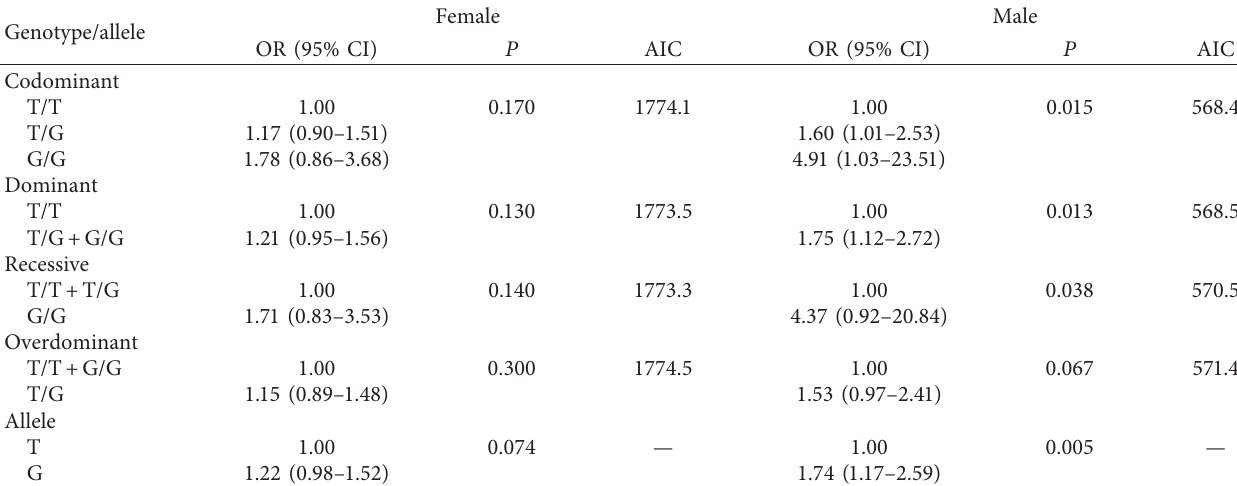
Table 9: Association between rs1443434 polymorphism and PTC by gender.